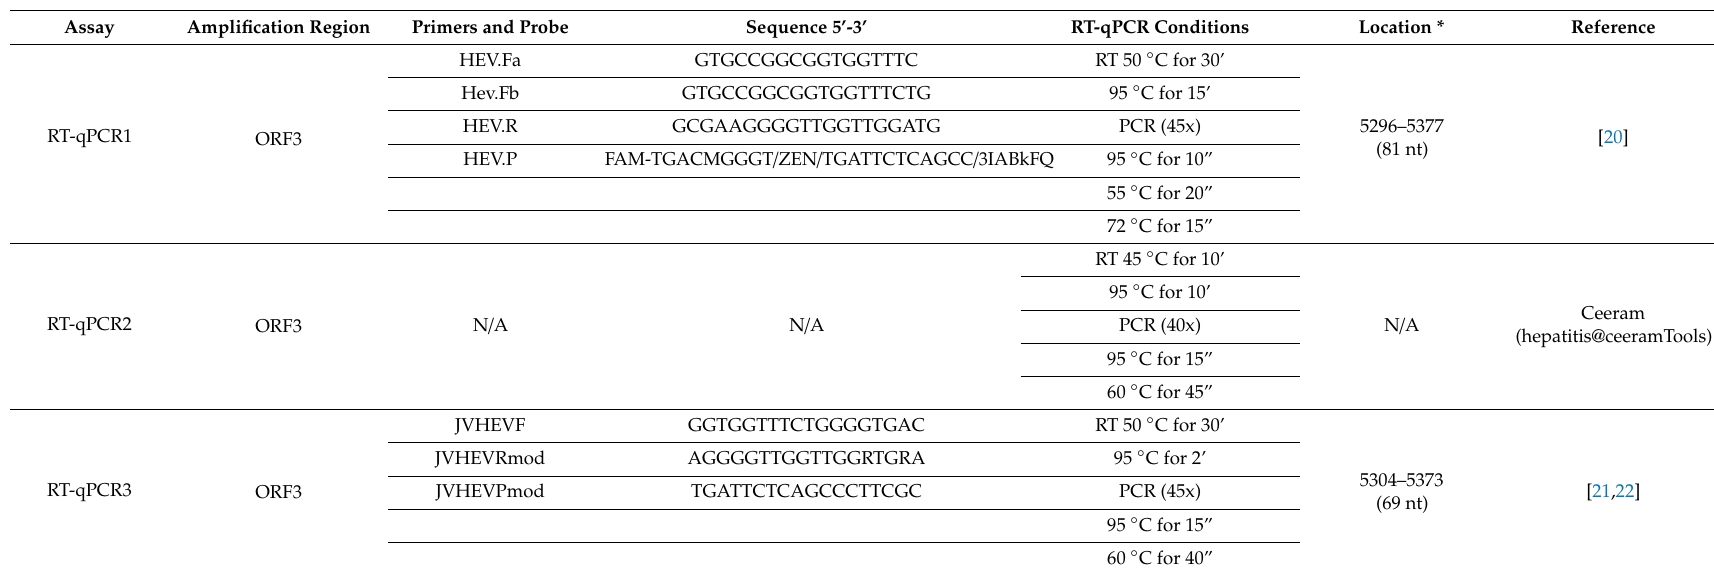
Table 1. Primers and probes used in this